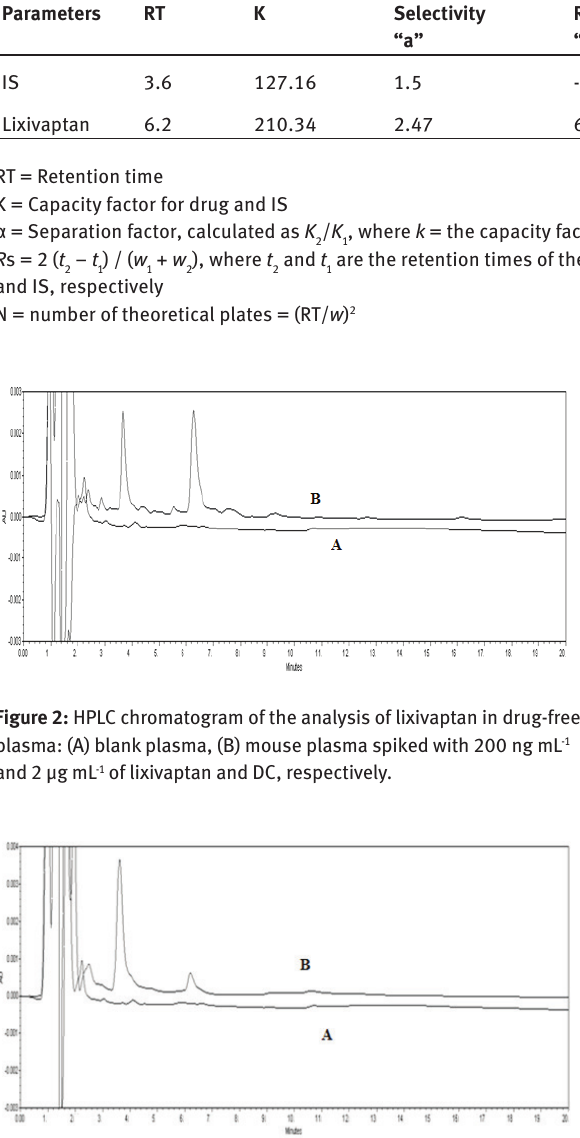
Figure 3: HPLC chromatograms of mouse plasma (A) at zero time (Blank) and (B) 0.5 h after injection.